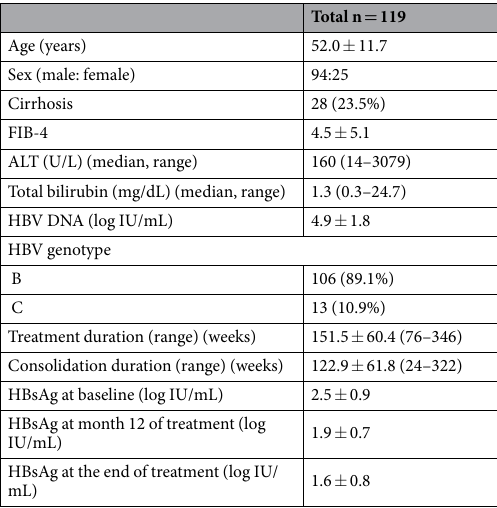
Table 1. Clinical characteristics of study